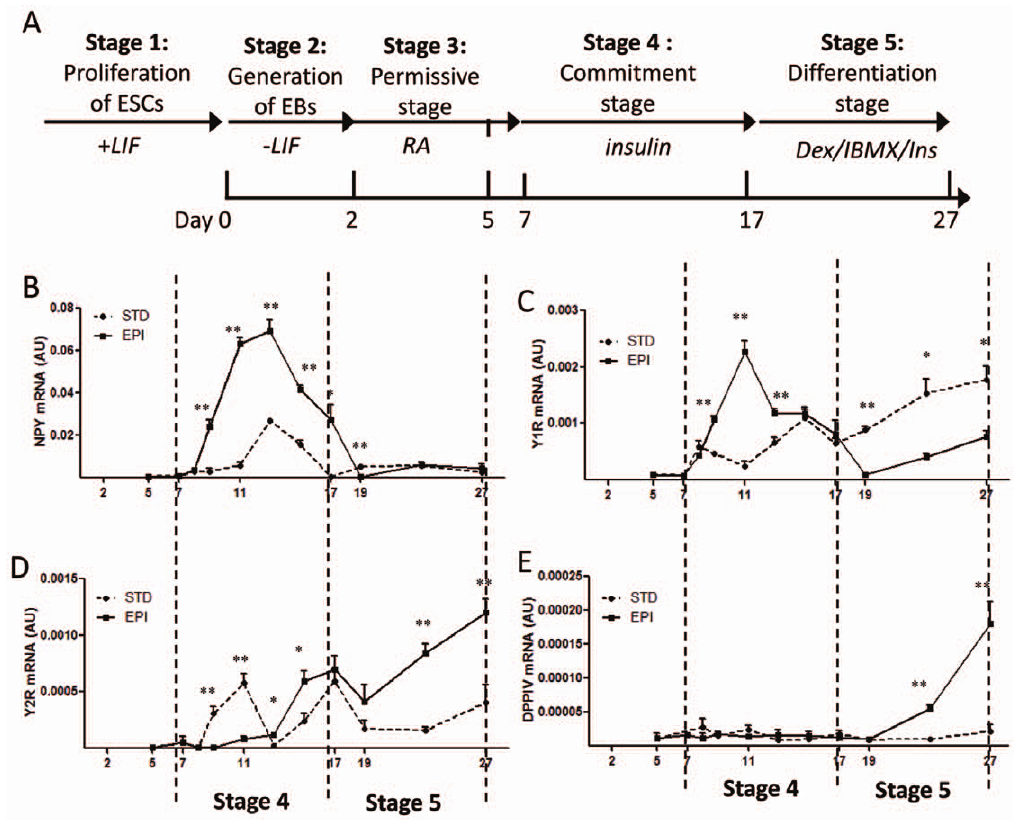
Figure 1. Epinephrine up-regulated the NPY system during mESCs adipogenesis. (A) Schematic representation of the strategy for differentiation of mESCs into adipocytes. (B–G) Gene expression analysis of NPY system during mESCs adipogenesis. EBs were treated with insulin (standard, STD) or insulin plus 1 m M EPI (EPI) from day 7 to day 17 during commitment stage, mRNA levels of NPY (B), Y1R (C), Y2R (D) and DPPIV (E) were measured by real time PCR. b -actin expression was used as an internal control. Values are from three separate experiments each performed in triplicate. *p , 0.05, **p , 0.01.